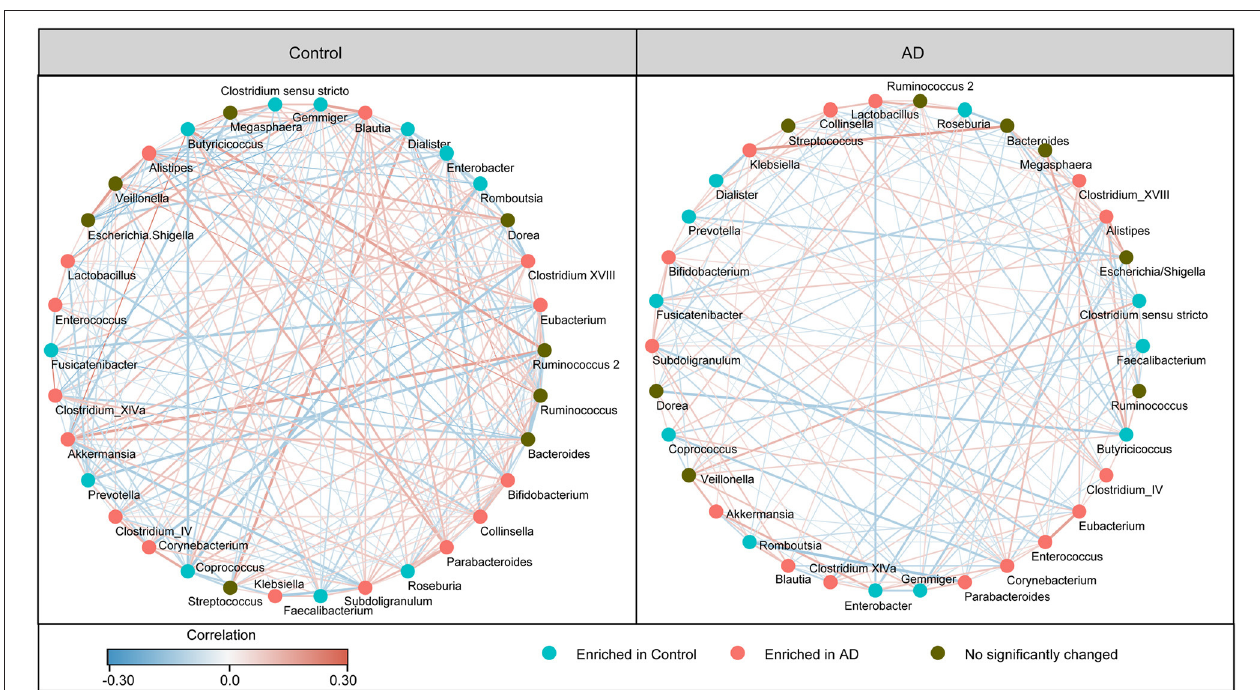
FIGURE 3 | Strengths of the correlation between abundant fecal microbiota in the Chinese AD patients and the healthy controls. Correlation network of the abundant fecal microbiota in the healthy controls and the AD patients. The correlation coefficients were calculated with the Sparse Correlations for Compositional (SparCC) data algorithm. Cytoscape version 3.4.0 was used for network construction. The red and blue lines represent positive and negative correlations, respectively. The correlation network became simpler in AD